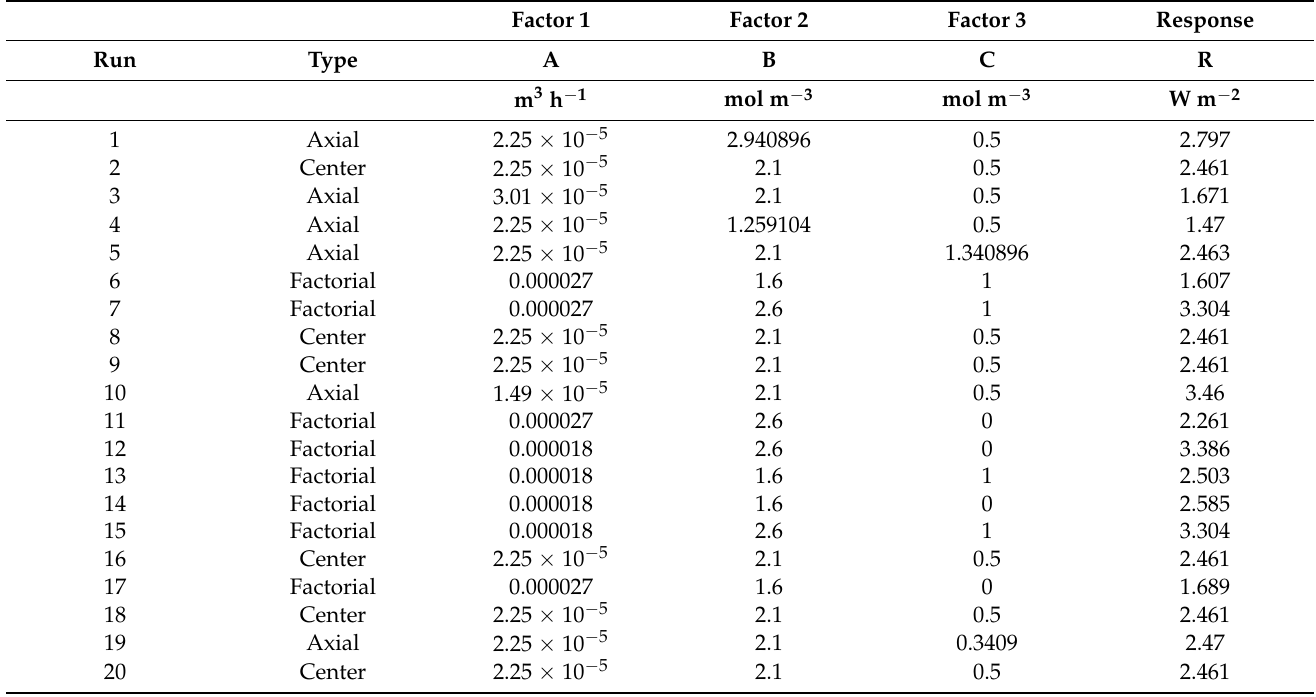
Table 3 lists all these experiments, with their corresponding values of power densities. Table 3. Central composite design of experiments for optimization of the